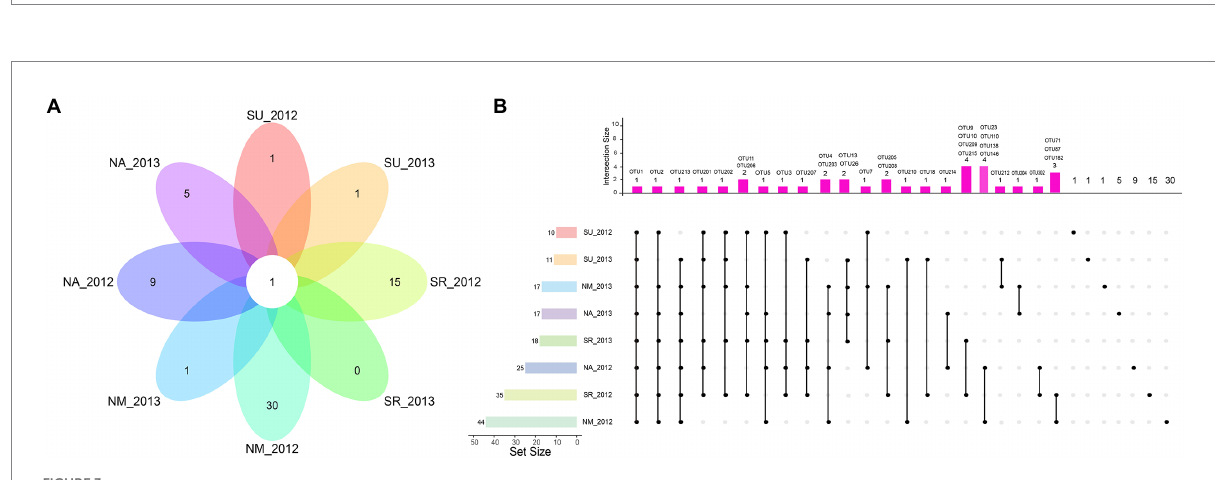
FIGURE 3 Venn plot for hub OTUs. (A) Flower plot shows the number of common and unique hub OTUs in eight experiments, (B) UpSet plot for eight experiments. Horizontal bars on the left represent the total number of hub OTUs in each experiment. Deep pink bars represent the number of hub OTUs of each intersection indicated by connected dots.